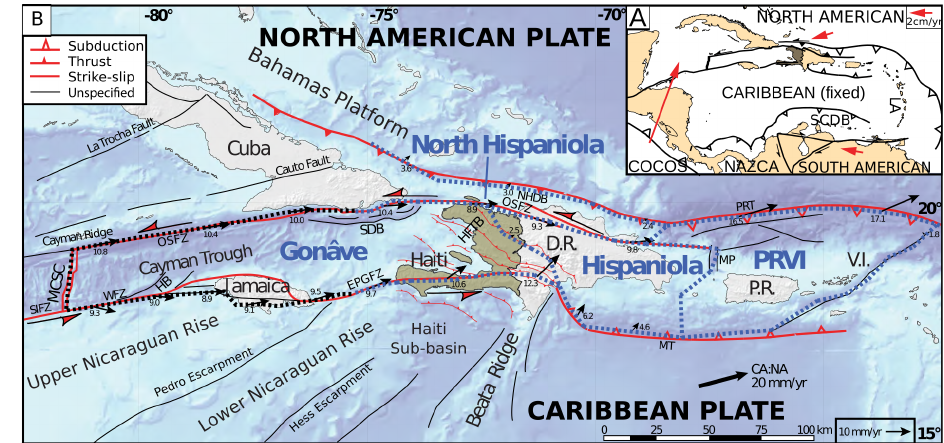
Figure 1. Map view of the Caribbean Plate northern boundary. (a) Geodynamic setting. GPS velocities (red arrows) with reference to a fixed Caribbean Plate are from DeMets et al. (2010). (b) Geodynamic setting of the northern Caribbean. Dashed lines delineate the Gonâve Microplate and Hispaniola, Puerto Rico–Virgin Islands and North Hispaniola blocks. Blue dashed lines and corresponding GPS velocity vectors are from Calais et al. (2016), while black dashed lines and corresponding GPS velocity vectors are from Symithe et al. (2015). Velocity vectors indicate the motion of the southern (western) boundary with reference to northern (eastern) boundary. Faults are modified after Leroy (1995). Caribbean–North American plate motion is from DeMets et al. (2010). Abbreviations are as follows: LA – Lesser Antilles; SCDB – South Caribbean deformed belt; SIFZ – Swan Island fault zone; MCSC – mid-Cayman spreading center; OSFZ – Oriente– Septentrional fault zone; SDB – Santiago deformed belt; NHDB – North Hispaniola deformed belt; MP – Mona Passage; PRT – Puerto Rico Trench; MT – Muertos Trough; HFTB – Haitian fold-and-thrust belt; EPGFZ – Enriquillo–Plantain Garden fault zone; HB – Hendrix pull-apart basin; WFZ – Walton fault zone; D. R. – Dominican Republic; P. R. – Puerto Rico; V. I. – Virgin Islands; and PRVI – Puerto Rico–Virgin Islands block. Modified from Wessels (2018).